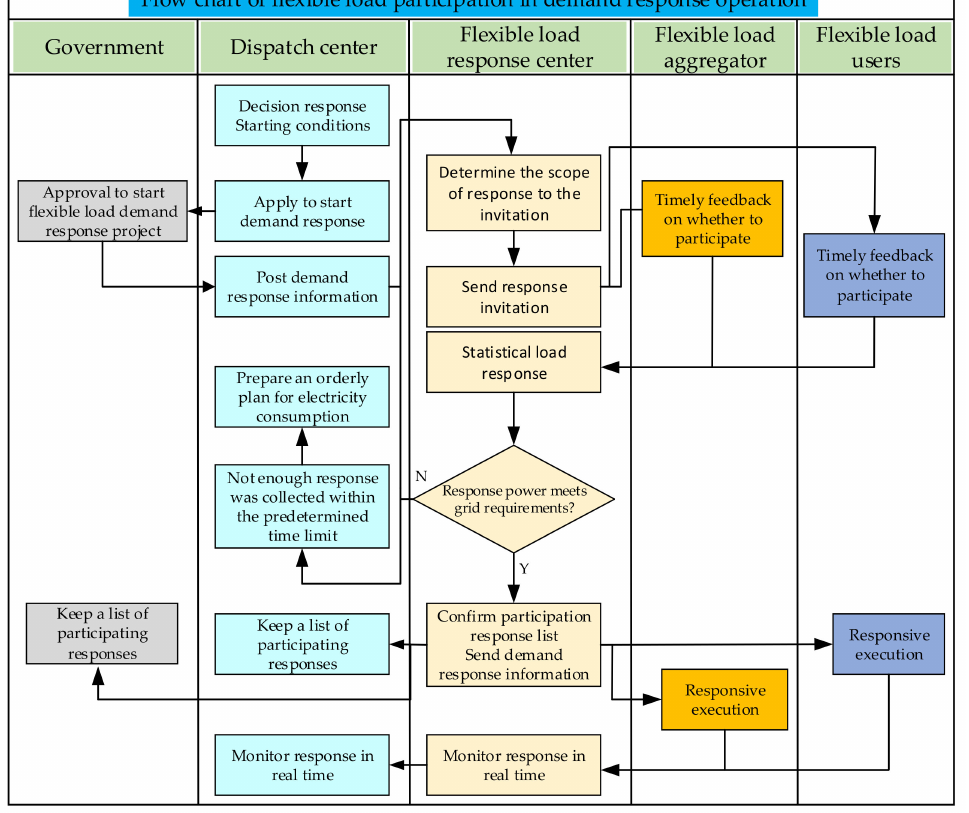
Figure 5. Flow chart of flexible load participation in demand response